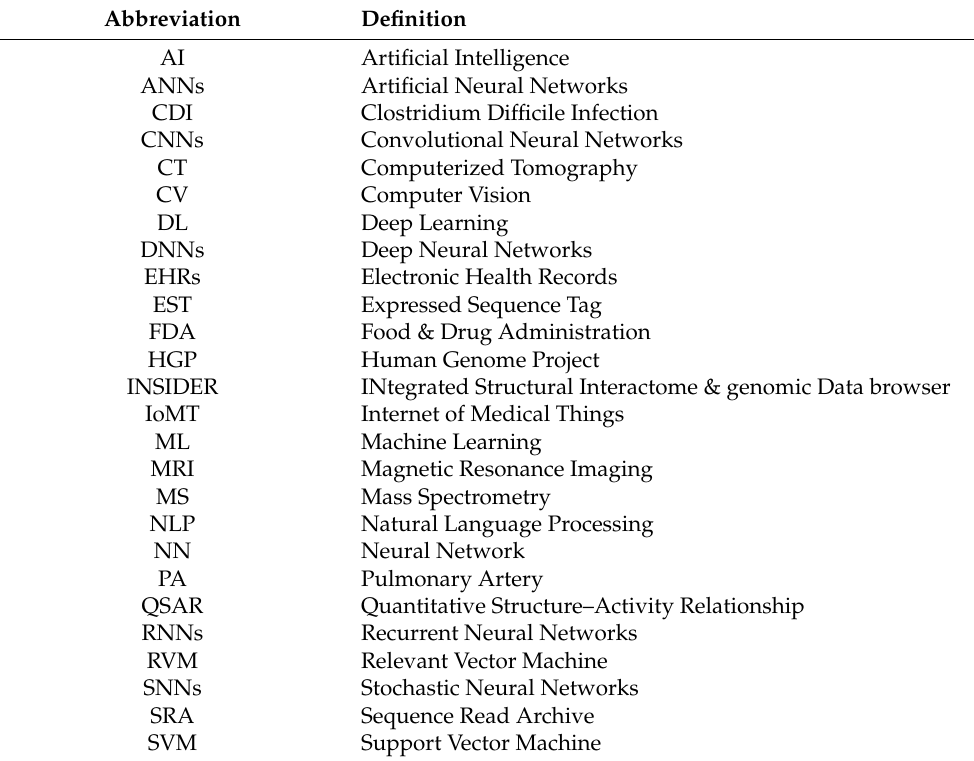
Table 1. List of abbreviations and